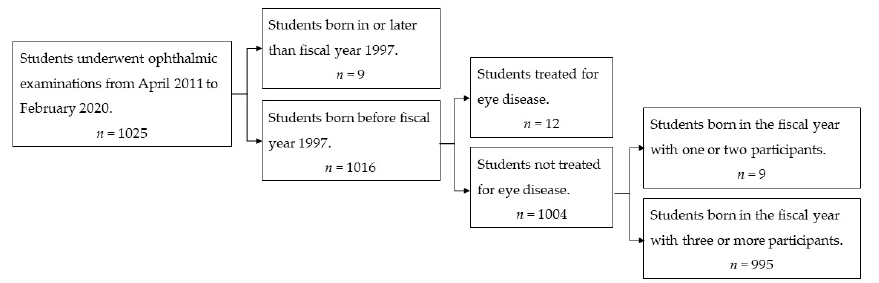
Figure 1. Study flowchart.